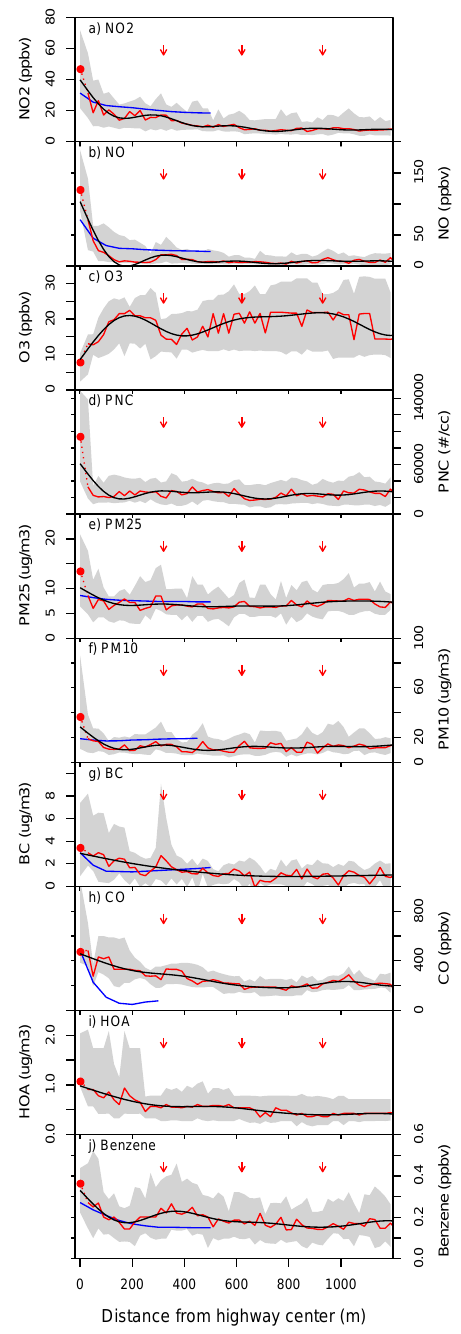
Figure 5. Median pollution levels (red line) and IQR (gray) at 20m bins for the entire study, showing NO 2 , NO, O 3 , PNC, PM 2 . 5 , BC, CO, traffic-related PM 1 (HOA) and benzene along the cross section marked in Fig. 2d. Arrows mark the locations of perpendicular roads meeting the cross section. Blue lines show the change in pollution from the edge of the road based on Fig. 3 from Karner (2010) and adjusted to CRUISER’s measurements at the edge of the road to fa- cilitate comparison. Black lines are a spline smoothing of the mea- surements. Red points mark measurements taken passing through the